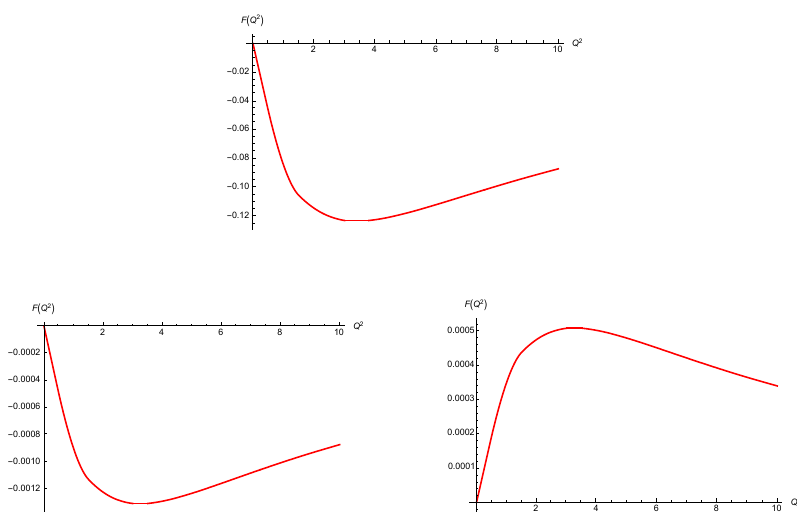
Figure 16. Form factors for the transitions from state No. 1 to the states with κ = 0,2 listed in Table 1. (Adapted from [1]). Upper panel: normal (No. 1, n = 1, κ = 0) → normal (No. 2, n = 2, κ = 0). Lower left panel: normal (No. 1, n = 1, κ = 0) → abnormal (No. 3, n = 1, κ = 2). Lower right panel: normal (No. 1, n = 1, κ = 0) → abnormal (No. 4, n = 2, κ =